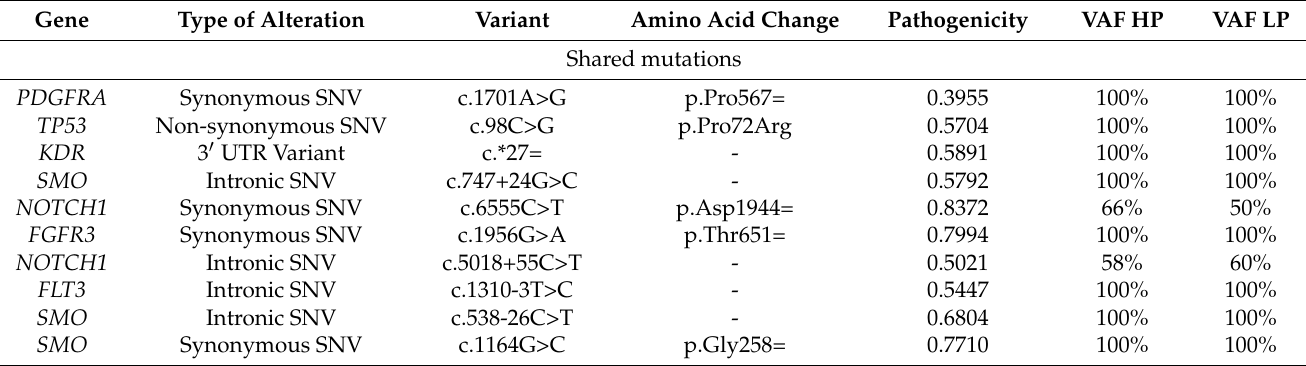
Table 6. Molecular characteristics of variants detected in tumor tissue of Patient